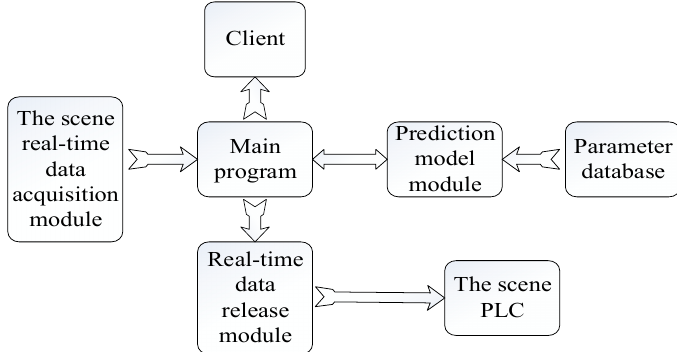
Figure 9. System modular structure diagram.